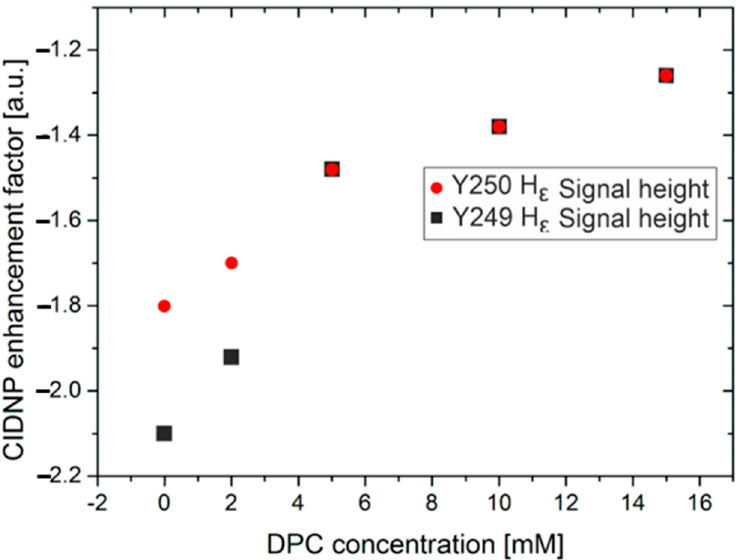
Figure 2. Photo-CIDNP enhancement of H ε signals of Tyr side chains (Y249 and Y250) as a function of DPC concentration. Signal height was used instead of integrals because Y249 is always partially overlapped with other signals at most DPC concentrations, resulting in wrong photo-CIDNP en- hancement factors for the integration approach. However, at least one of the spins of the doublet of Y249 was free of overlap (at least for 0–15 mM of DPC) and could be therefore used for the determi- nation of the photo-CIDNP enhancement factors. In the presence of 2 mM of DPC, the photo-CIDNP enhancement factor of the epsilon proton of Y249 varied by 8.6%, while the epsilon proton of Y250 varied by 5.5%, illustrating the higher accessibility of the former to the solvent.